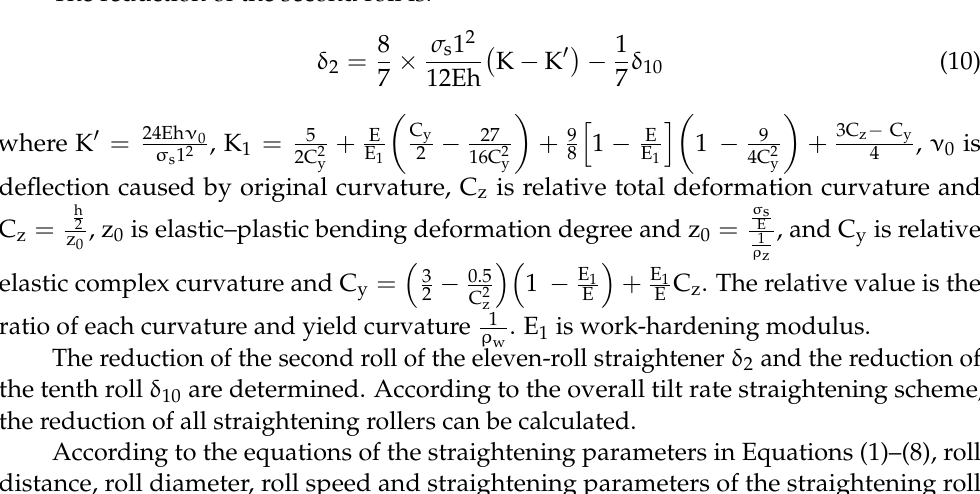
Table 3. Reduction of upper straightening roll. Roll Number